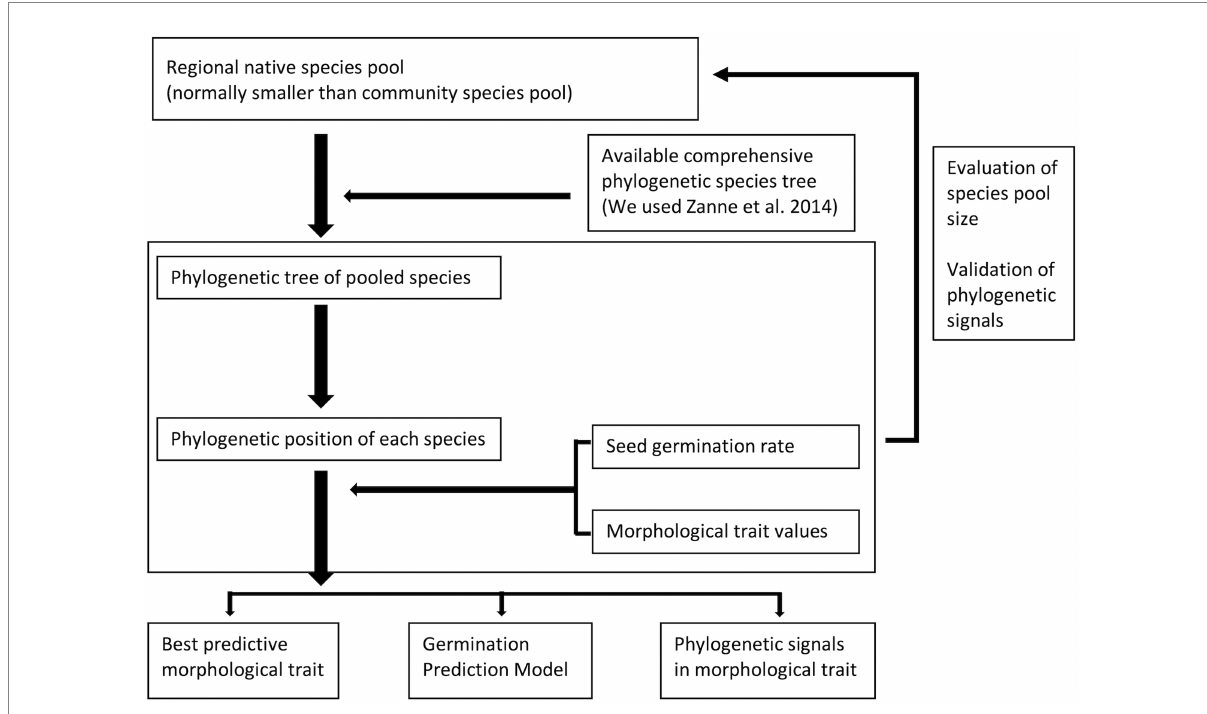
FIGURE 6 General protocol for generating a germinability prediction model with phylogenetic information for a plant community. This model needs a pool species with phylogenetic information, morphological data and germination data to build. It will be able to explore the germination pattern of the